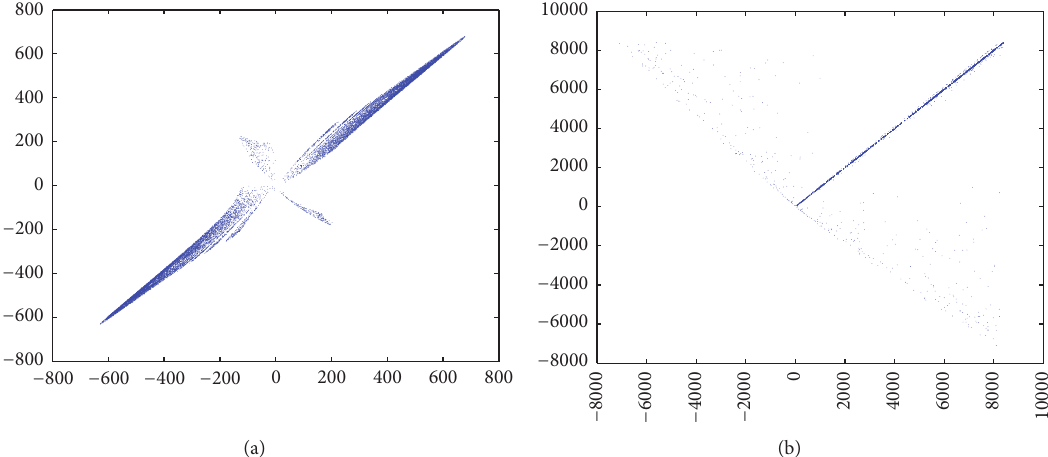
Figure 16: First return map for the chaotic-transient solution. (a) 𝑋 -component; (b) 𝑌